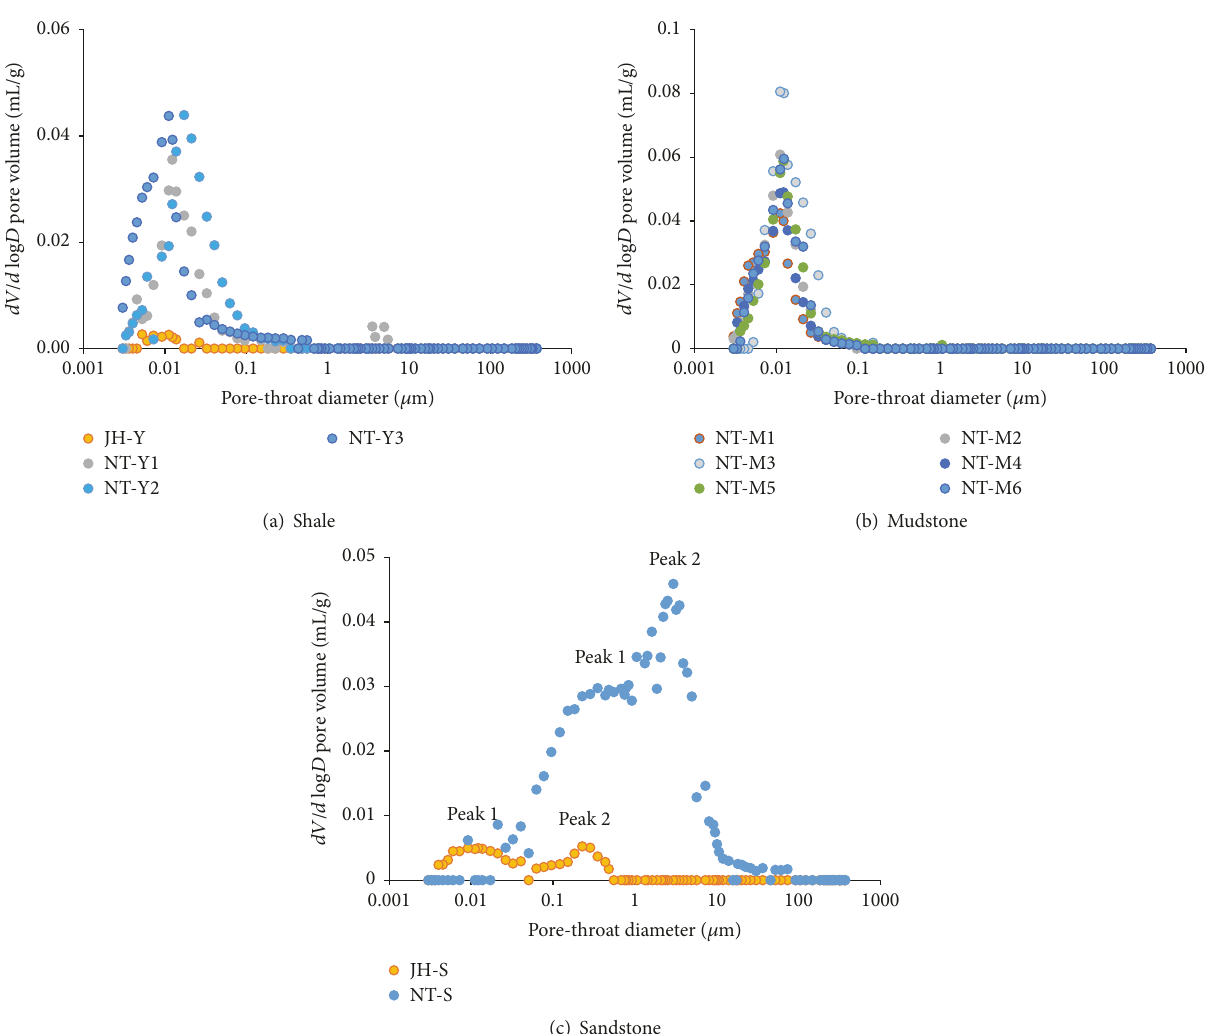
Figure 7: Pore size distribution curves of the investigated samples obtained from the MIP measurements.